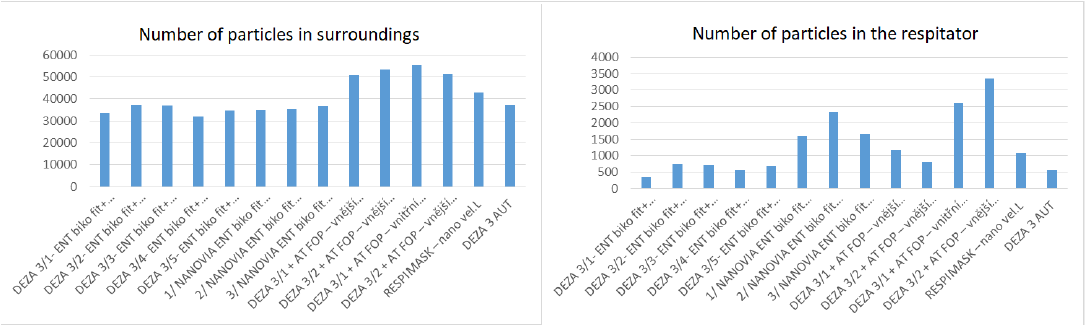
Figure 15. Results of the assessment of the respirators made from different construction materials in terms of the efficiency of capture of the submicron particles.